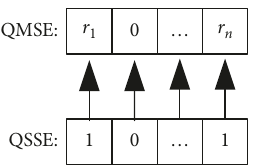
Figure 1: Mapping relation between QSSE and